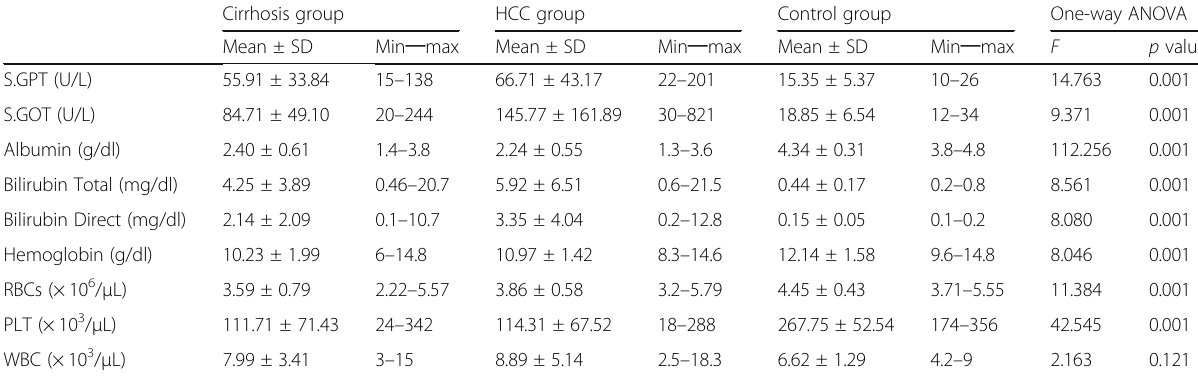
Table 6 Data of liver function test and CBC in cirrhosis, HCC, control group Cirrhosis group HCC group